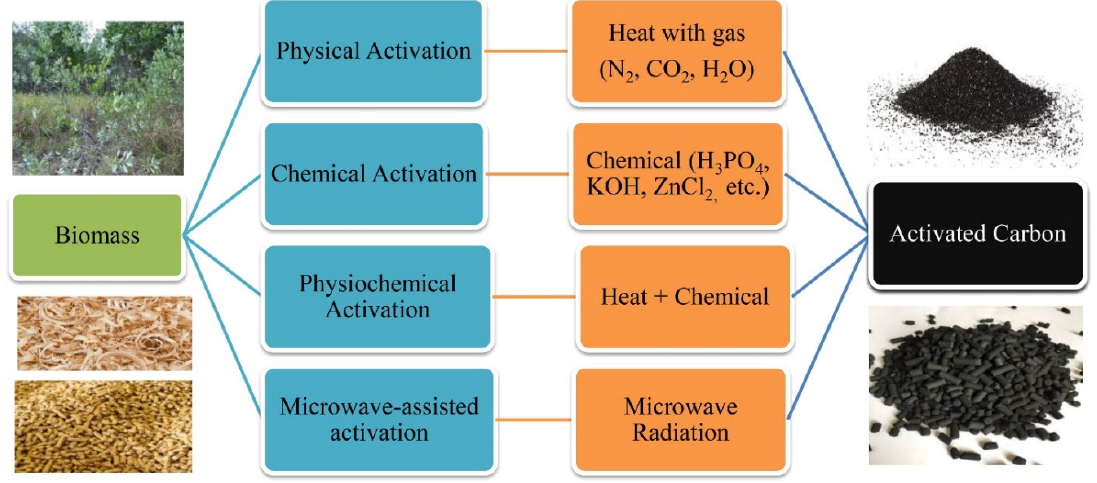
Figure 2. Synthesis of activated carbon by various processes and activating reagents [36].